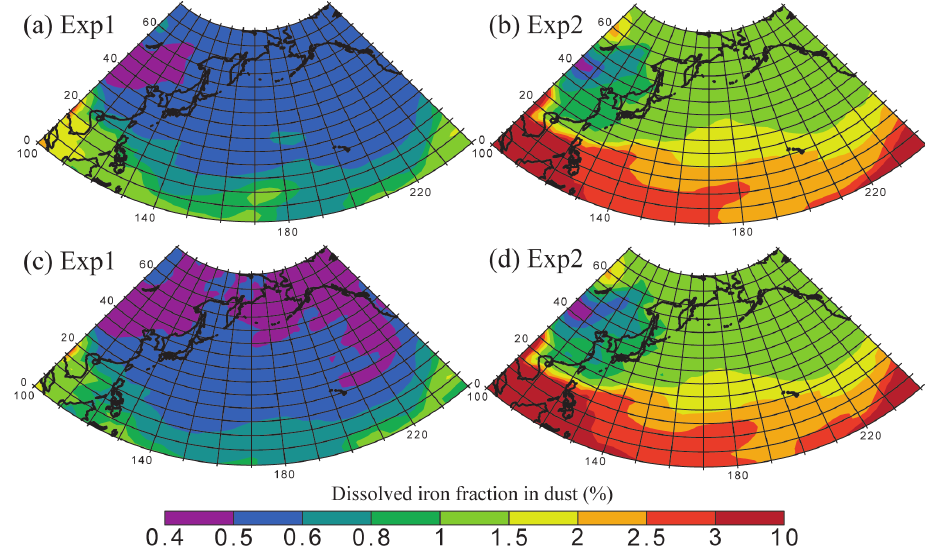
Fig. 4. Modeled dissolved iron fraction (DIF) in dust (%) in the surface air during April 2001 for (a) the fine mode with the alkaline dust, (b) the fine mode without the alkaline dust, (c) the coarse mode with the alkaline dust, and (d) the coarse mode without the alkaline dust.